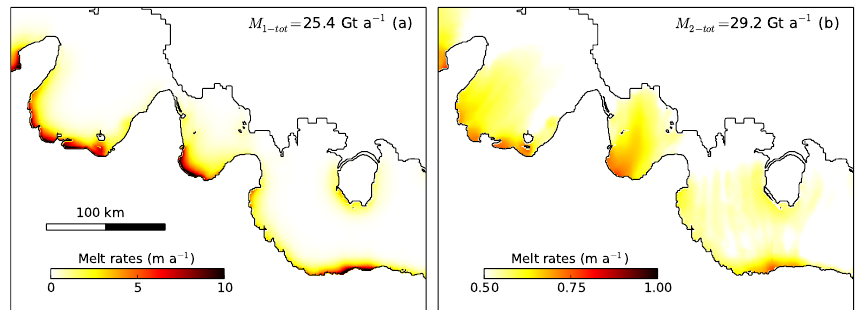
Figure 3. Initial fields of medium M b1 (a) and M b2 (b) sub-ice-shelf melt rates for the B e /S initialisation. The sum of melt rates over the computational domain, written at the top right of panels, is comparable to current values (Rignot et al., 2013; Depoorter et al., 2013, and M. Depoorter, personal communication, 2016; Table S1).